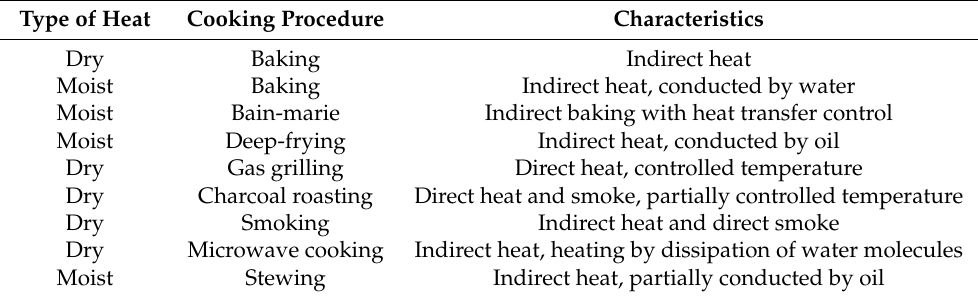
Table 3. Types of food